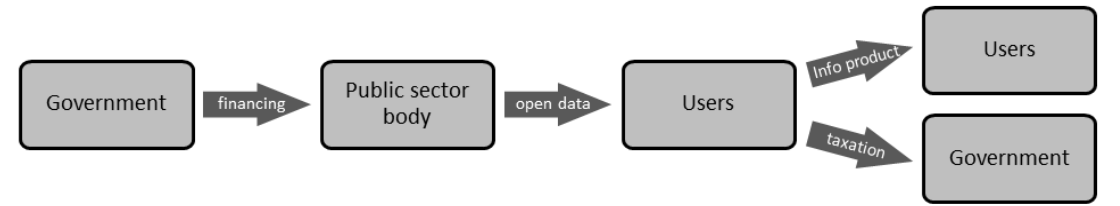
Figure 2: Open data policy (P. Boers (personal communication April 17, 2015) after van Loenen 2006,